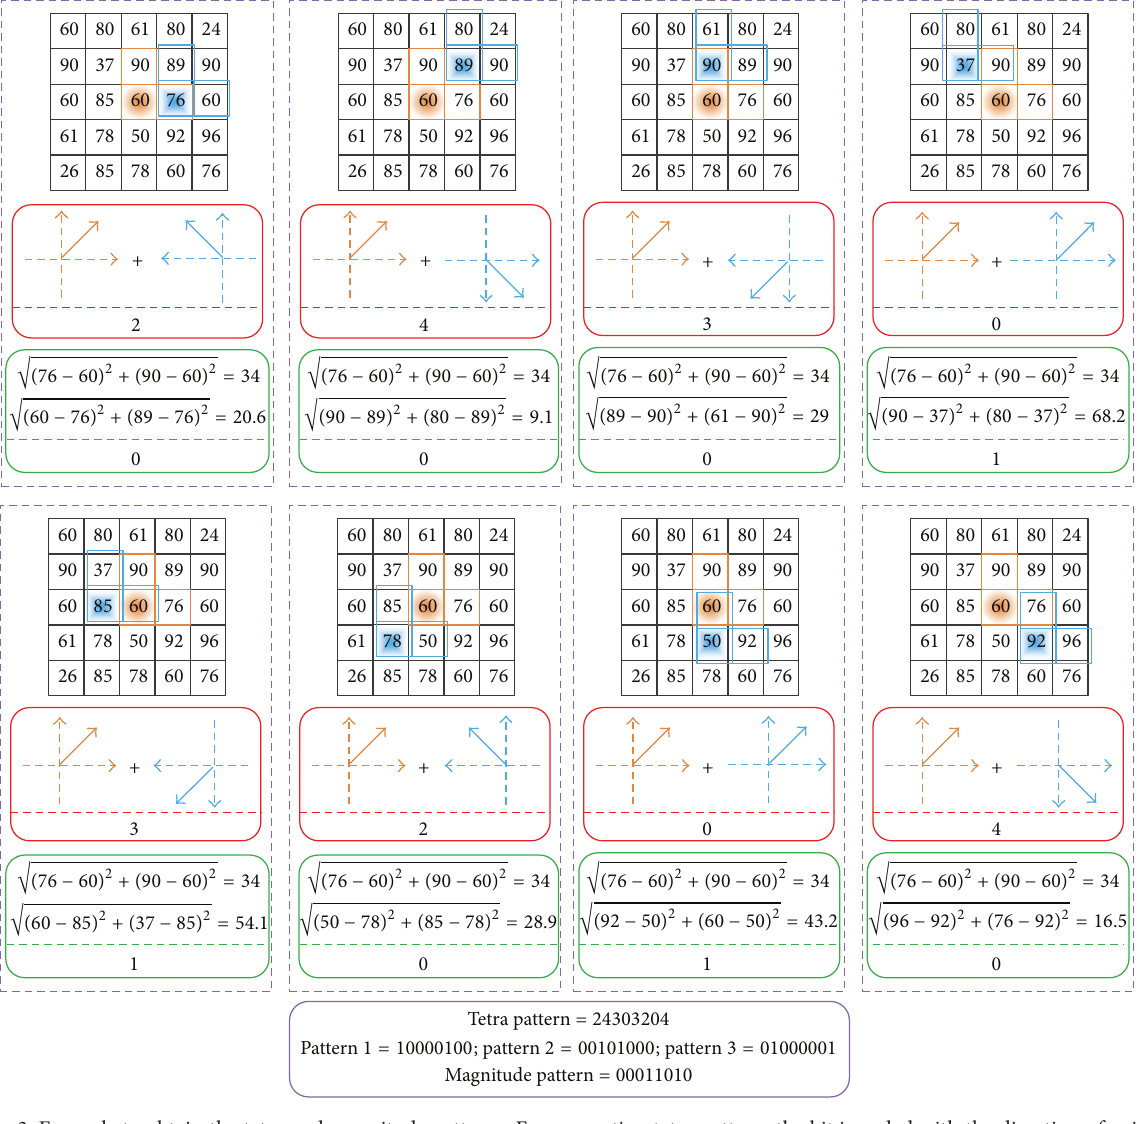
Figure 3: Example to obtain the tetra and magnitude patterns. For generating tetra pattern, the bit is coded with the direction of neighbor when the direction of the center pixel and its neighbor are different, otherwise “0,” which are represented in red rounded rectangle. Then convert the tetra patterns for each direction to three binary patterns, that is, “Pattern 1” to “Pattern 3” in bottom purple rounded rectangle. For generating the magnitude pattern, which is defined in (11), the bit is coded with “1” when the magnitude of the center pixel is less than its neighbor, otherwise “0,” and the binary magnitude coding is given in bottom purple rounded